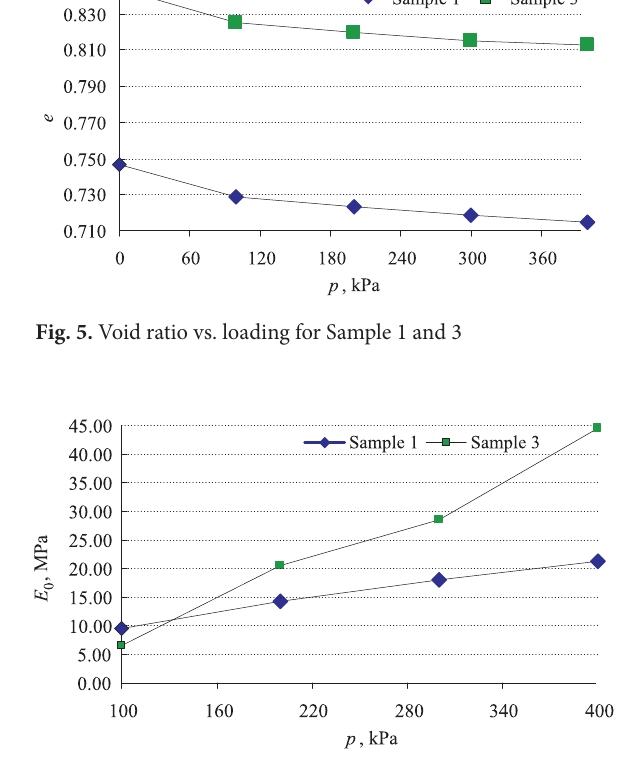
Fig. 6. Oedometric modulus vs. loading for Sample 1 and 3